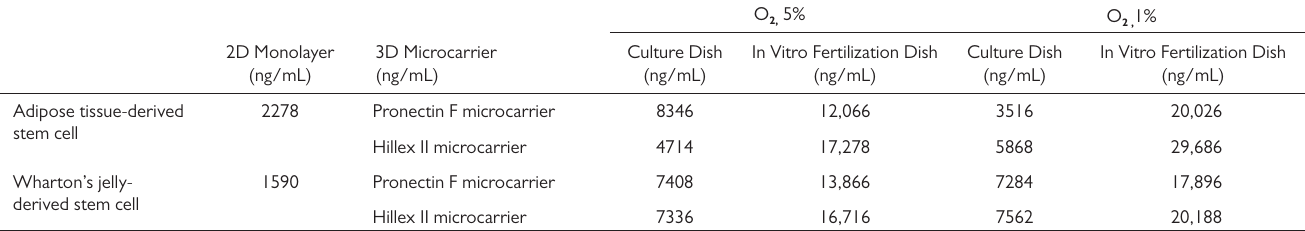
Table 1. Brain-Derived Neurotrophic Factor Levels in Mesenchymal Stem Cell Culture Fluid Under Different Culture Conditions